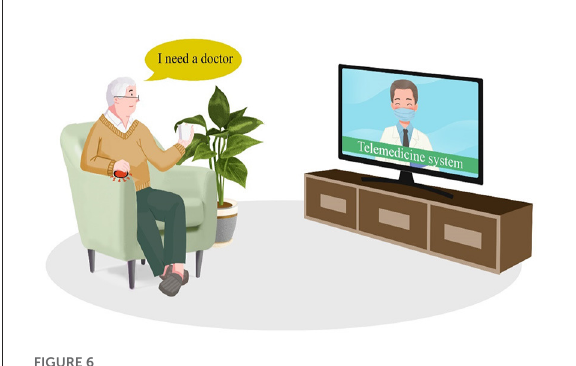
FIGURE6 Simplified delivery of CMEC services.